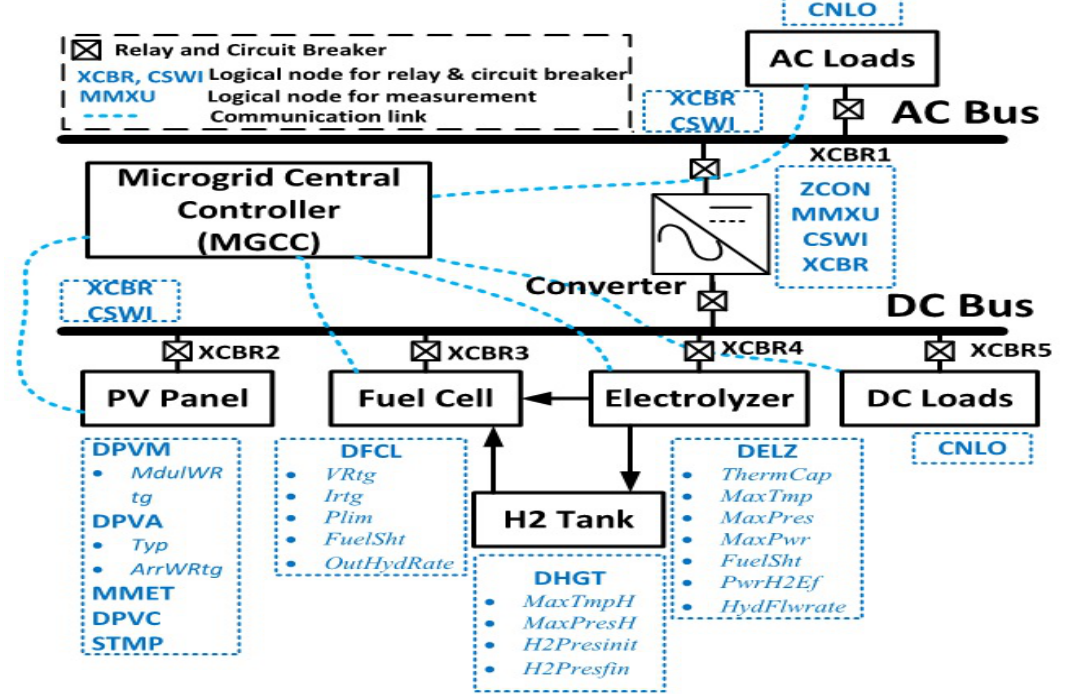
Figure 9. IEC 61850 communication model of FC-PV hybrid